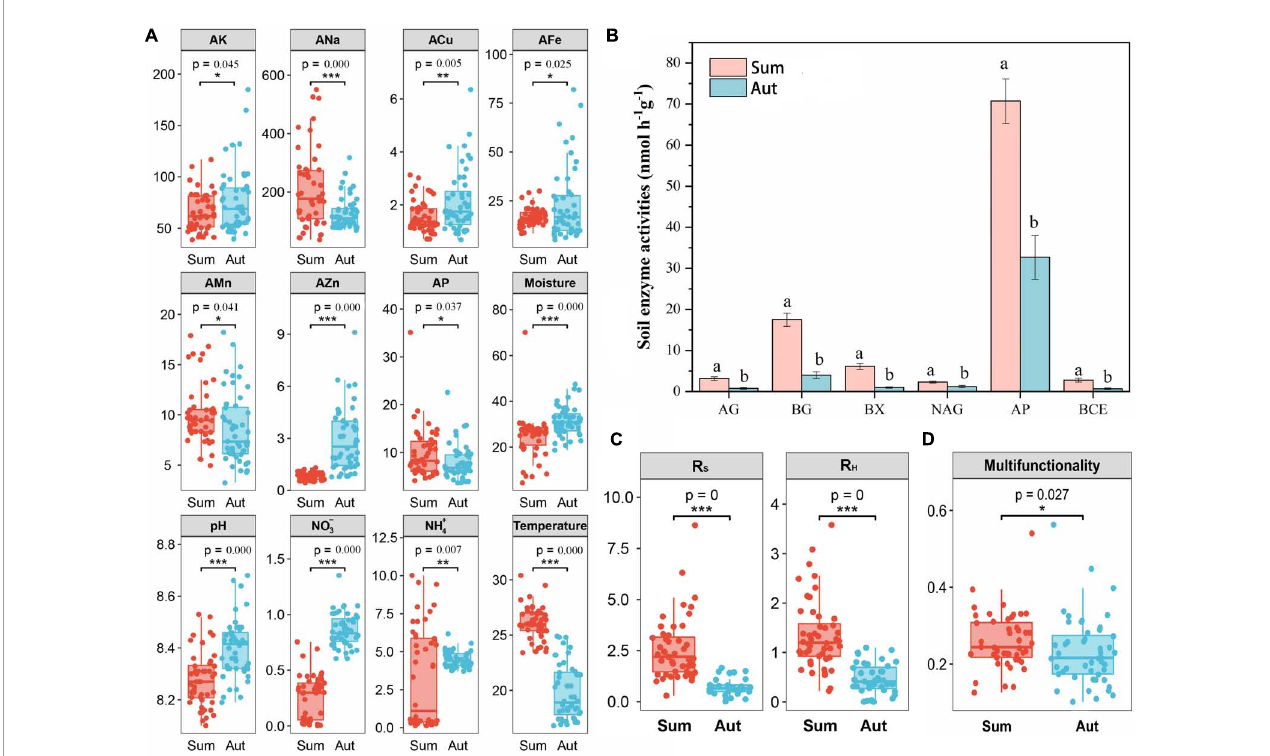
FIGURE2 Soil physical, chemical, biological properties and multifunctionality. (A) Soil properties in summer and autumn; (B) soil extracellular enzyme activities in summer and autumn; (C) soil respiration in summer and autumn. (D) Soil multifunctionality in summer and autumn. Sum, summer; Aut, autumn; R S , soil respiration; R H , soil heterotrophic respiration; AK, available potassium; ACa, available calcium; AMg, available magnesium; ANa, available sodium; ACu, available copper; AFe, available iron; AMn, available manganese; AZn, available zinc; AP, available phosphorus. AG, α -glucosidase; BG, β -glucosidase; BX, β -Xylosidase; NAG, N-acetyl- β -glucosaminidase; ALP, alkaline phosphatase; BCE, β -D-cellobioside. Data (a and b) that do not share a letter are significantly different between treatments ( P < 0.05). * P < 0.05, ** P < 0.01, and *** P <